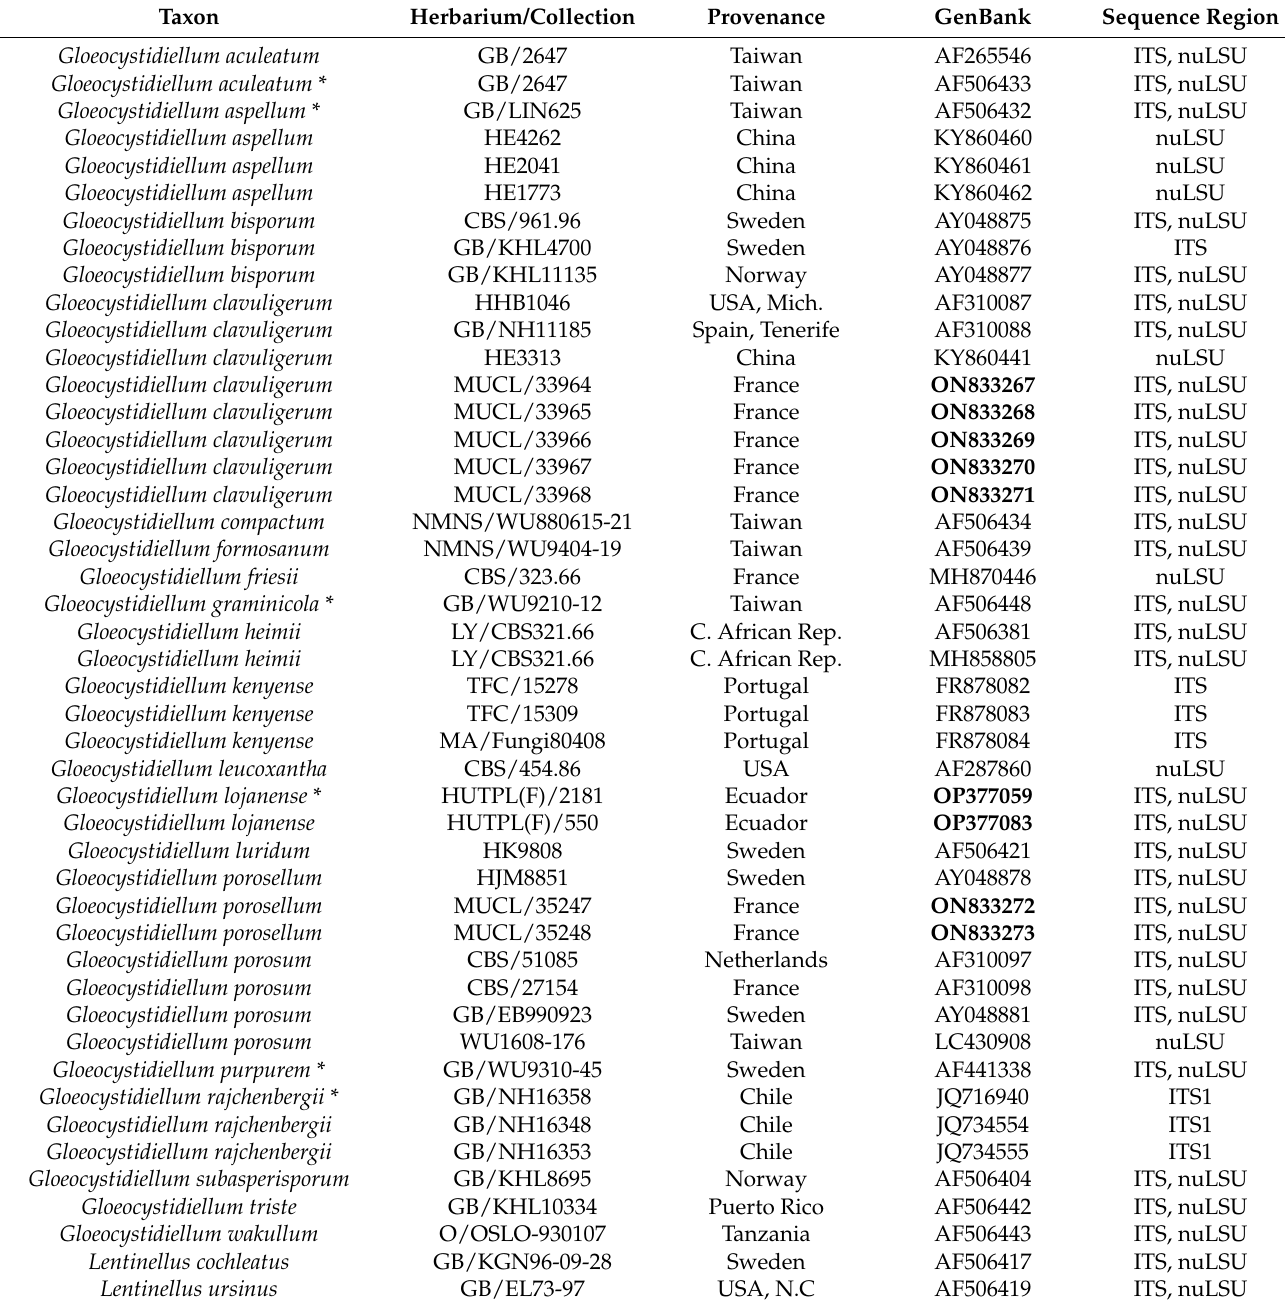
Table 1. GenBank sequences reference applied in molecular analyses in this